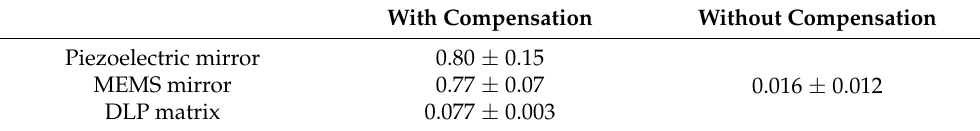
Table 1. Comparison of return-to-fiber efficiency for different aberration-compensation methods.